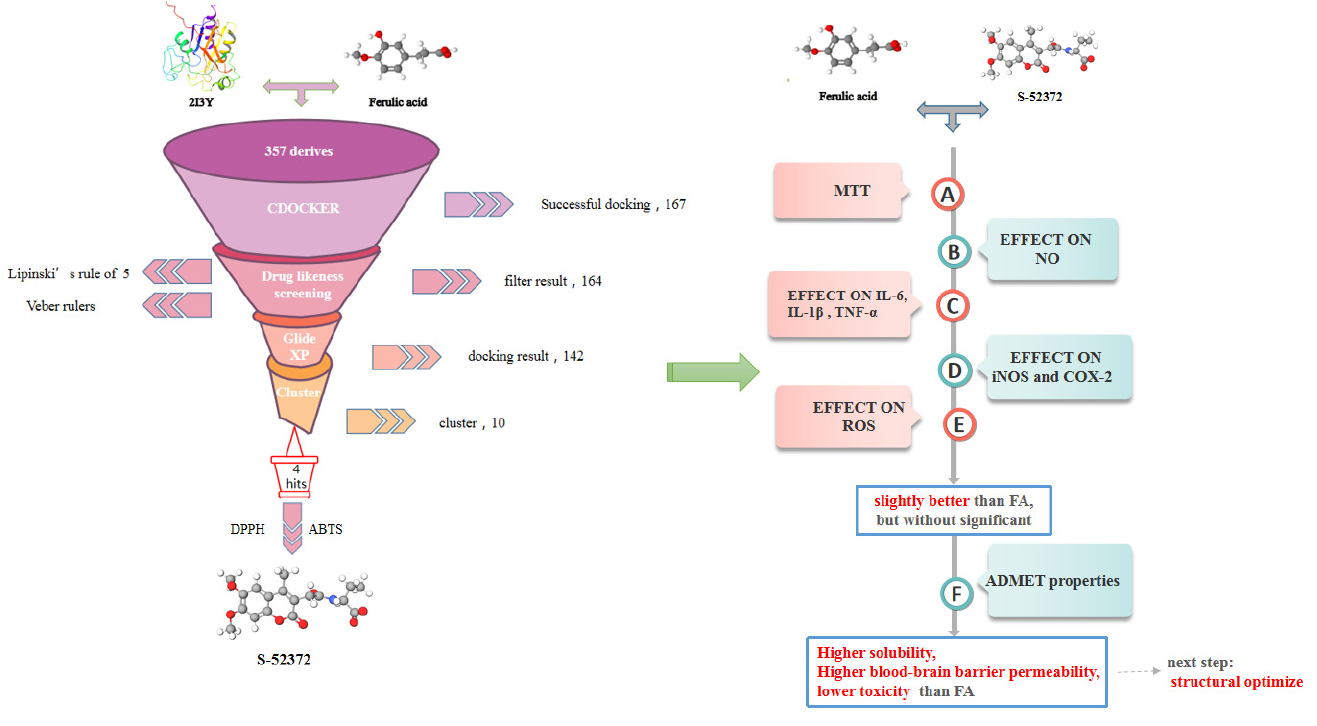
Figure 1. The whole process in this study.